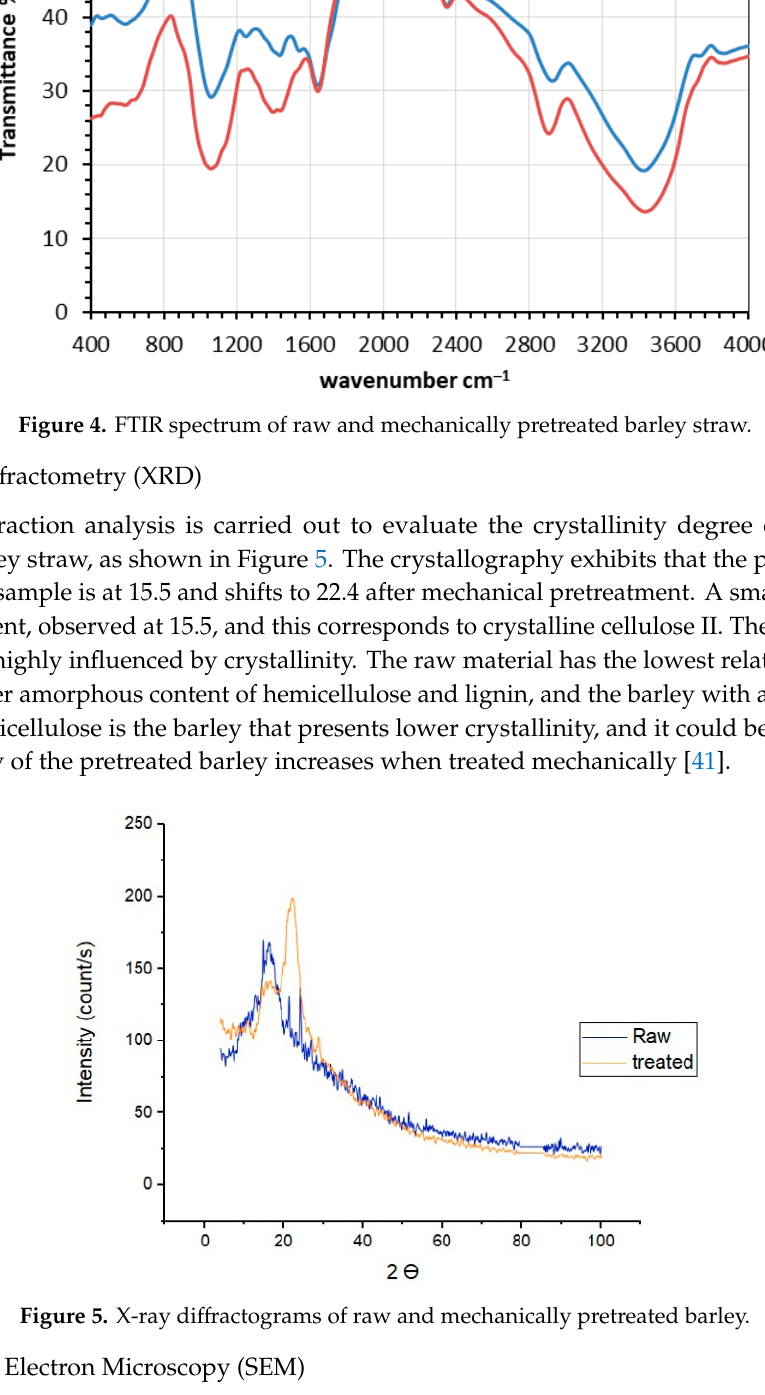
Figure 5. X-ray diffractograms of raw and mechanically pretreated barley.